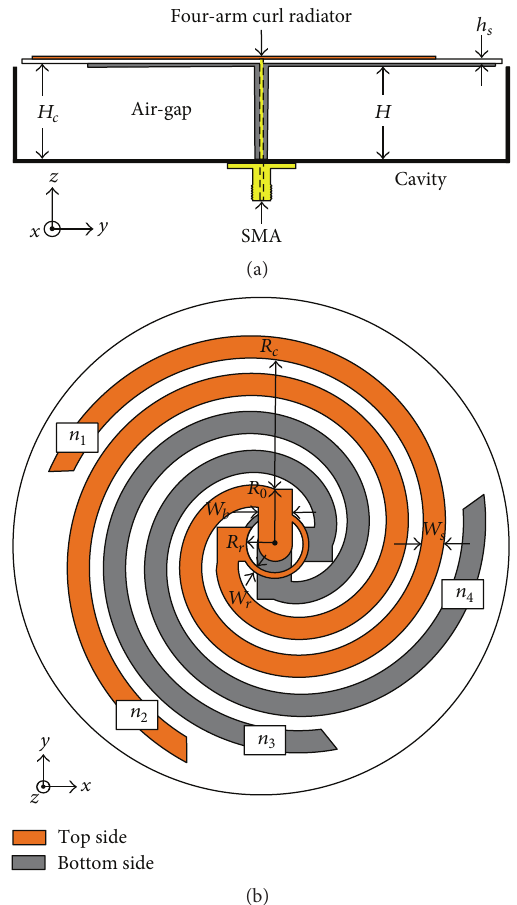
Figure 1: Geometry of the proposed antenna: (a) cross-sectional view with the cavity-backed reflector and (b) top view of radiator.